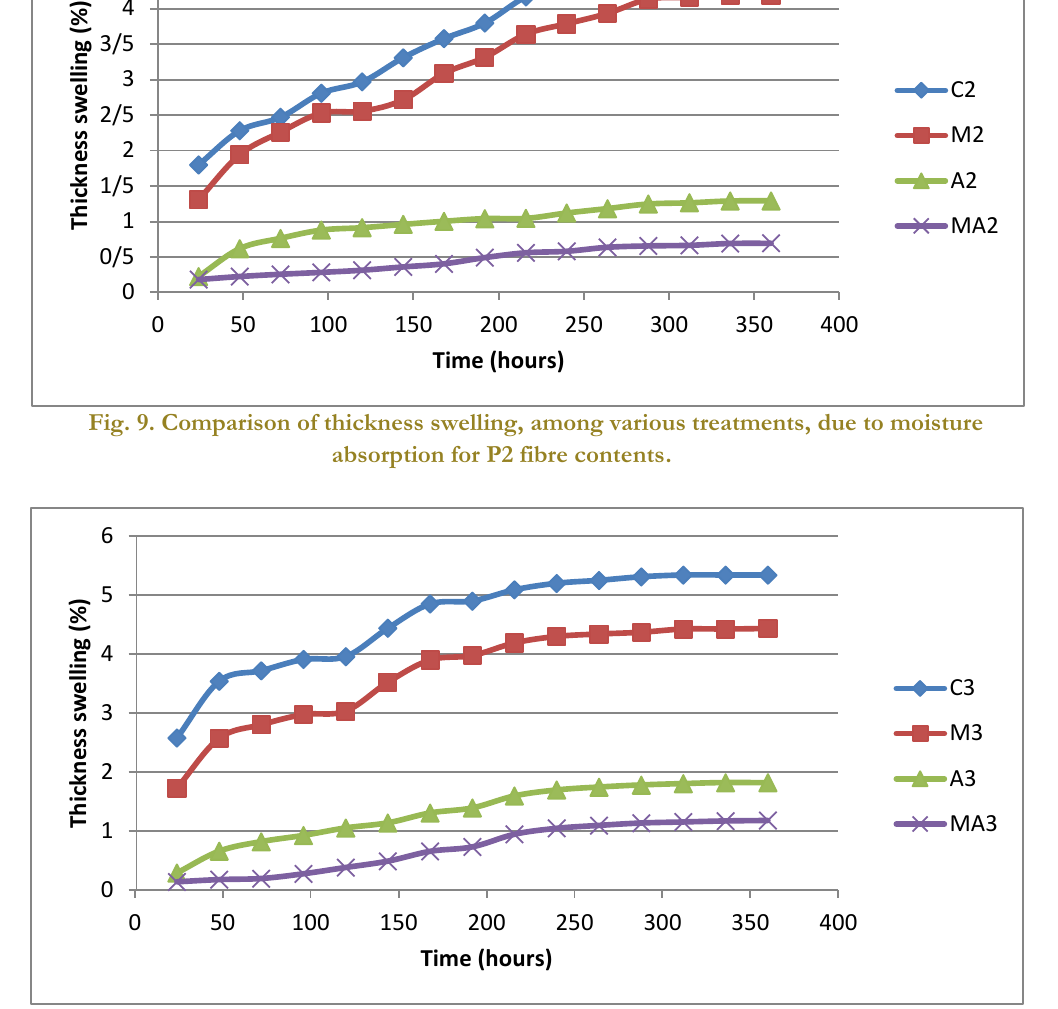
Fig. 10. Comparison of thickness swelling, among various treatments, due to moisture absorption for P3 fibre contents.